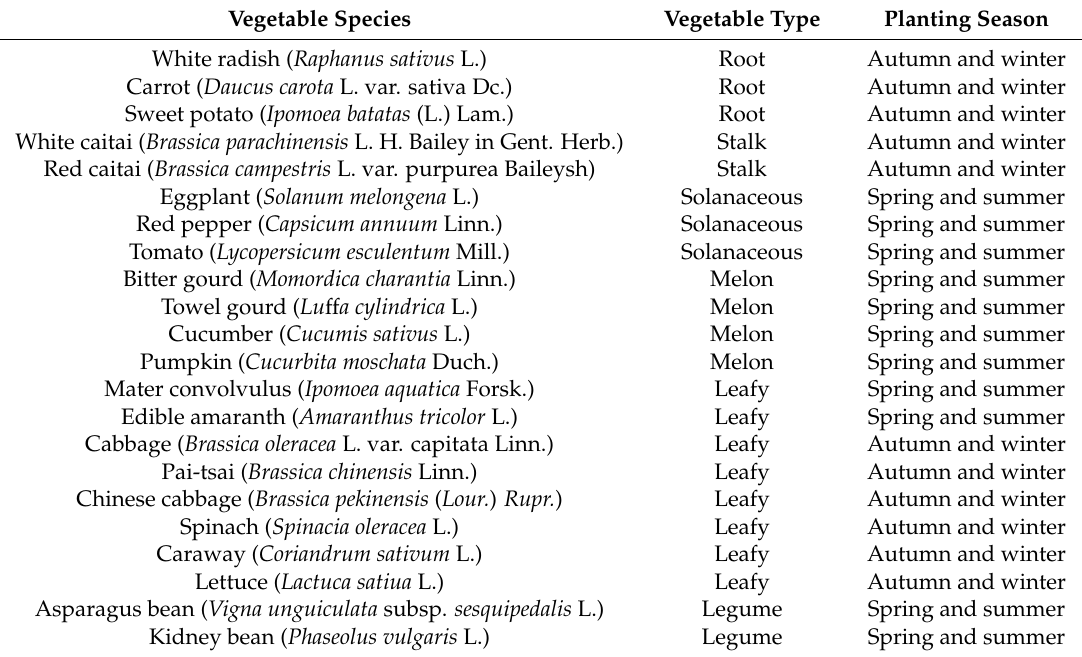
Table 2. Vegetable species used in the